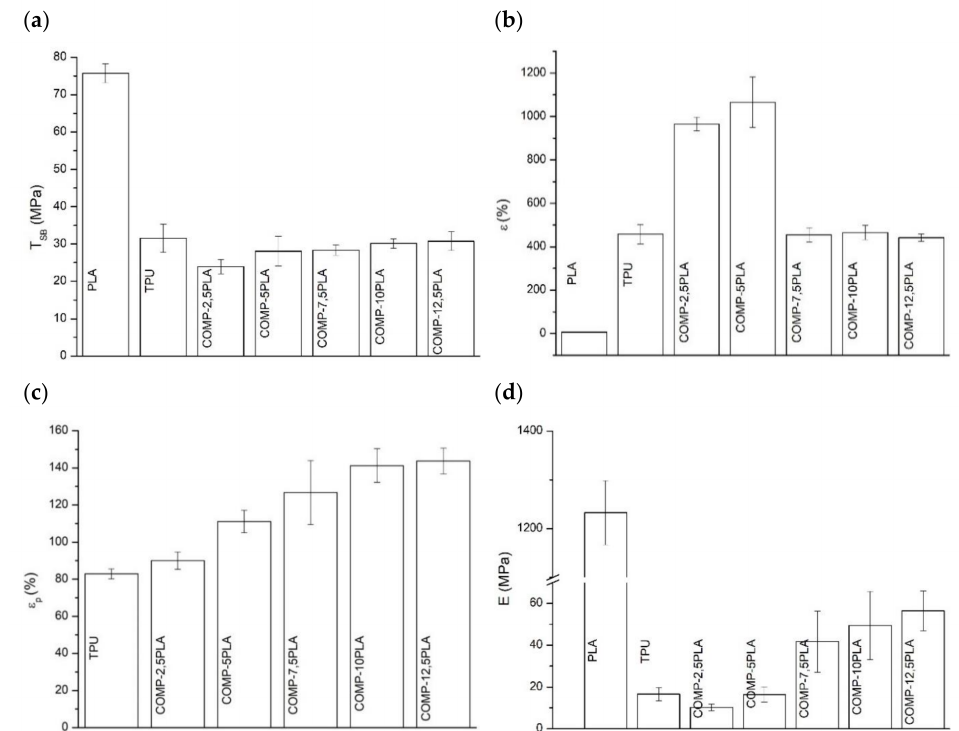
Figure 3. Tensile test results ( a ) tensile strength (T Sb ), ( b ) elongation at break ( ε ), ( c ) permanent elongation ( ε p ) of the obtained compositions and ( d ) Young’s modulus (E).